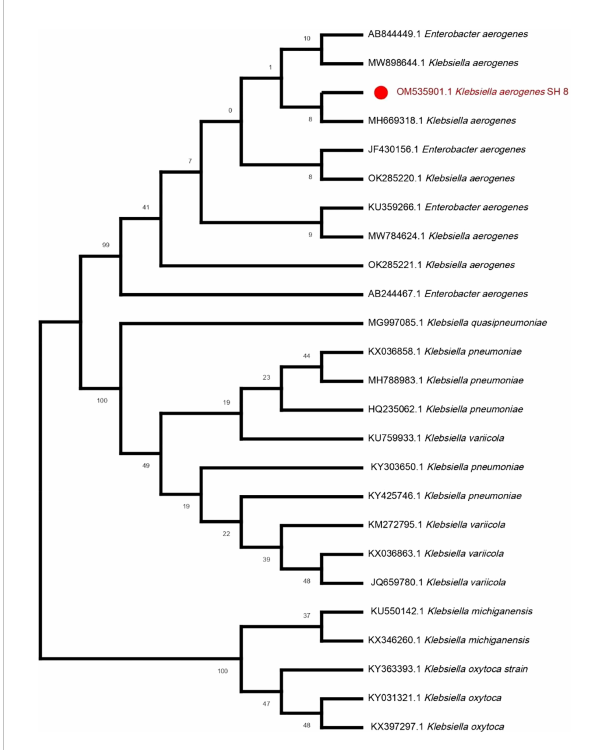
FIGURE 2 The phylogenetic tree of Klebsiella aerogenes SH-8 was constructed from 16S rRNA sequences using the ML method with the aid of the MEGA X program.